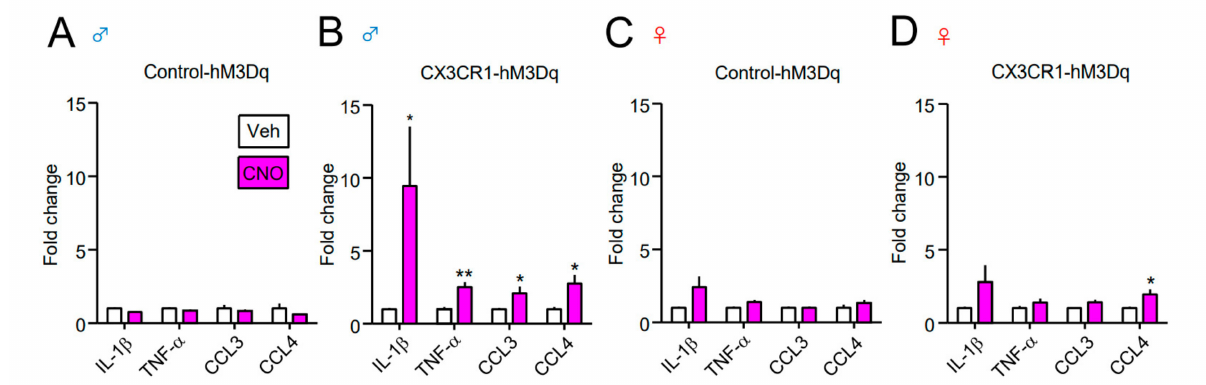
Figure 4. Upregulation of inflammatory mediators in the spinal cord of male CX3CR1-hM3Dq mice. CNO (2 nmol) or Veh was i.t. administered to naïve Control-hM3Dq and CX3CR1-hM3Dq mice of both sexes ( A , B ; male, C , D ; female), and the spinal cord was collected one day after administration. The mRNA expression of inflammatory mediator (interleukin 1 β (IL-1 β ), tumor necrosis factor α (TNF- α ), C-C motif chemokine ligand 3 (CCL3), and CCL4) was analyzed by RT-qPCR. Data are presented as mean ± SEM. n = 6 − 9. **, p < 0.01. *, p < 0.05. vs. Veh.